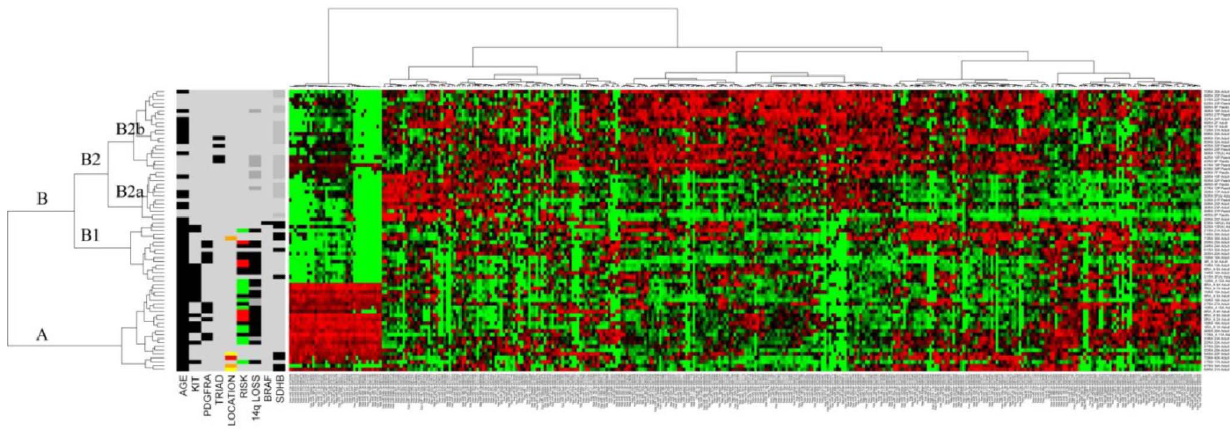
Figure 1. Full heatmap generated from complete miRNA expression data for all 73 cases. Included at the left of heatmap are case data to include adult/pediatric categorisation, anatomic location of tumor, KIT , PDGFRA and BRAF mutational status, risk stratification for adult mutant cases, and, where available: Carney triad status, SDHB-immunoreactivity and 14q genomic status of tumor. Black=positive for feature listed. For age, black=adult, grey=pediatric; for KIT/PDGFRA/BRAF black=mutation positive while grey=WT; Black=Carney triad diagnosed; for anatomic location of tumor, grey=stomach, red=retroperitoneum, yellow=jejunum; orange=ileum; for risk, red=low, black=intermediate, green=high, grey=unavailable. For 14q loss and SDHB status, black=positive; dark grey=tested and negative, grey=not tested. The clusters are designated A, B, with sub-clusters B1 and B2, B2a and B2b to facilitate discussion of findings. doi:10.1371/journal.pone.0064102.g001 PLOS ONE |